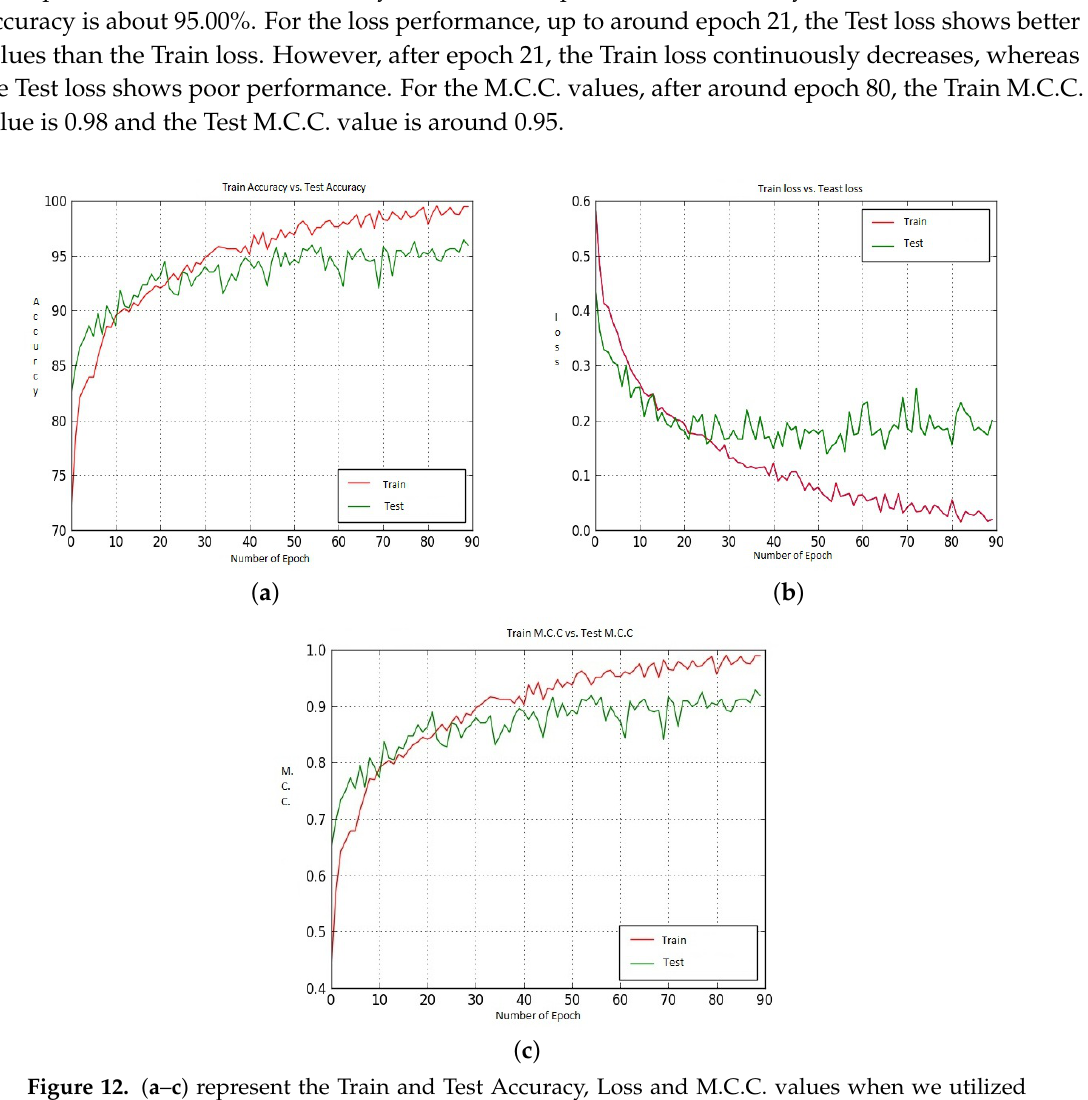
Figure 12. ( a – c ) represent the Train and Test Accuracy, Loss and M.C.C. values when we utilized Model-1, CNN-CH on the 100 ×